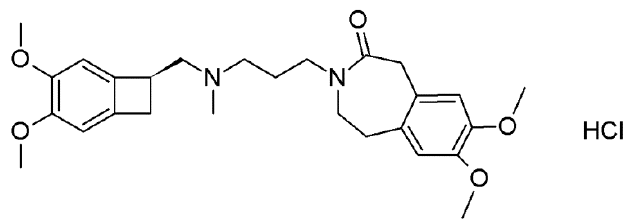
Figure 1. Molecular formula of ivabradine hydrochloride.